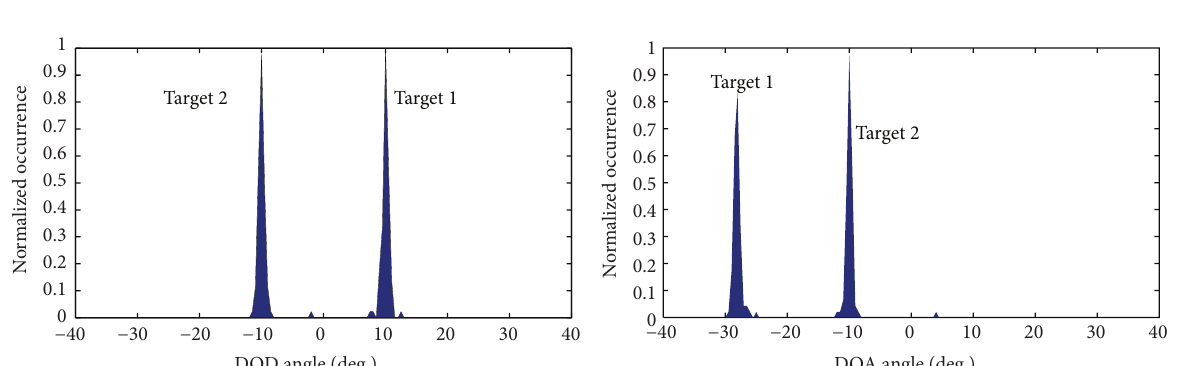
Figure 3: Formulation of angle histograms from two-way MUSIC spectra at each frequency